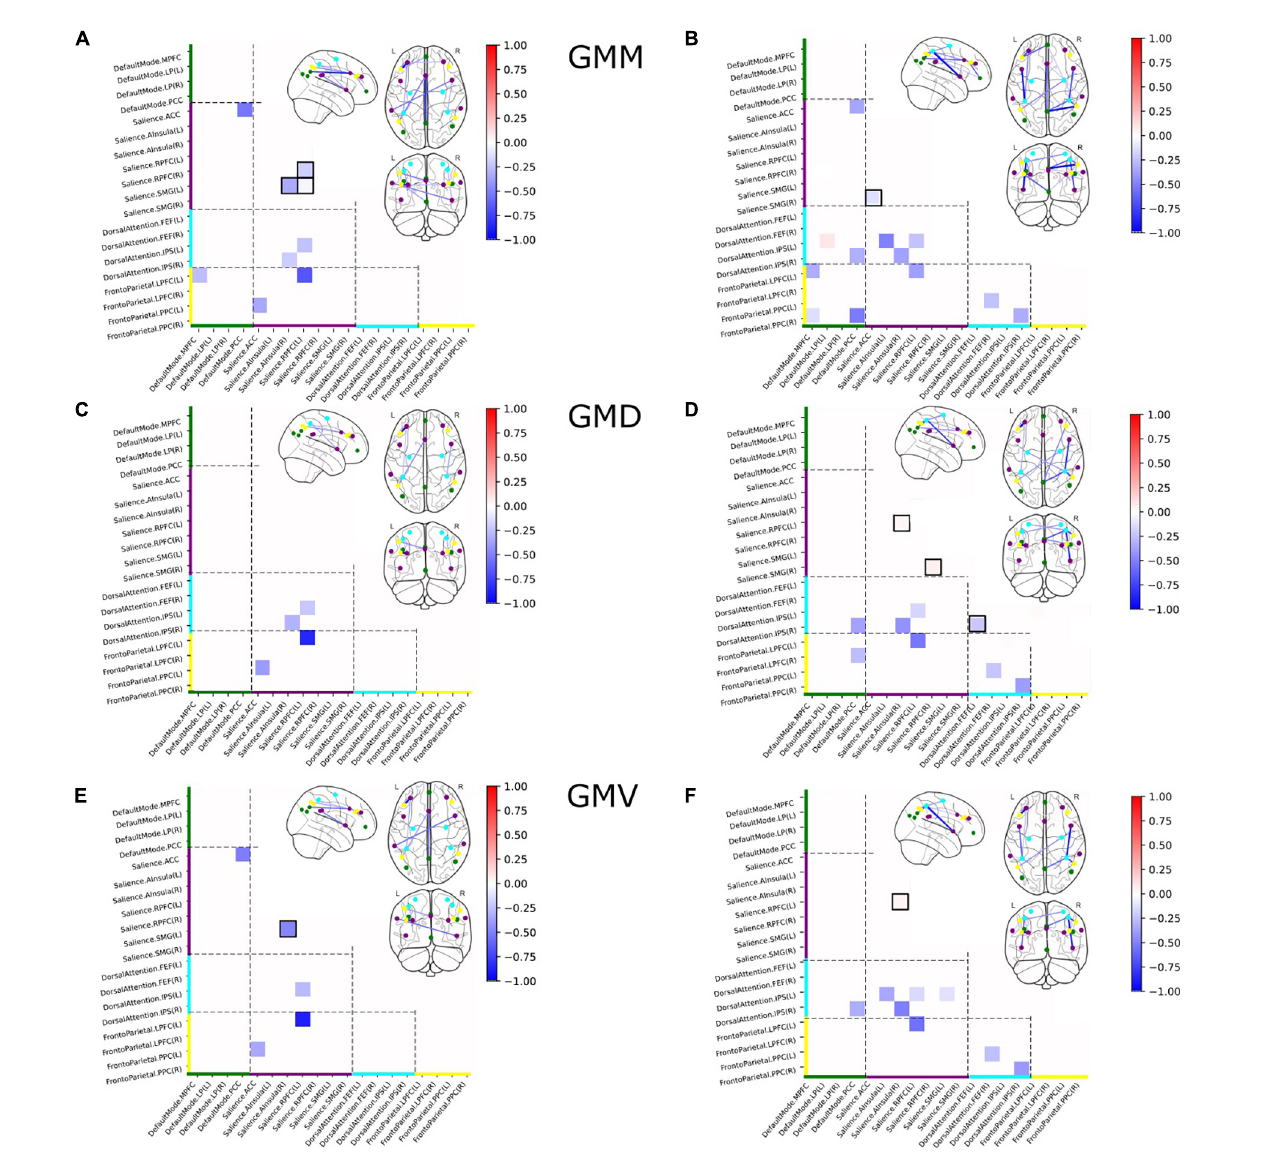
FIGURE3 Group differences in structural covariance of gray matter masses (GMM) (A) , gray matter densities (GMD) (C) , and gray matter volumes (GMV) (E) within and between four major brain networks for the full sample, and group differences in structural covariance of GMM (B) , GMV (D) , and GMD (F) within and between four major brain networks for the subsample of subjects with a current psychiatric diagnosis. Squares indicate significant differences in partial correlations between V and NV. Colors on the axes and of the nodes correlated with the networks: DMN–green, SN–purple, DAN–cyan, FPN–yellow. Nodes with within-network differences were highlighted with black